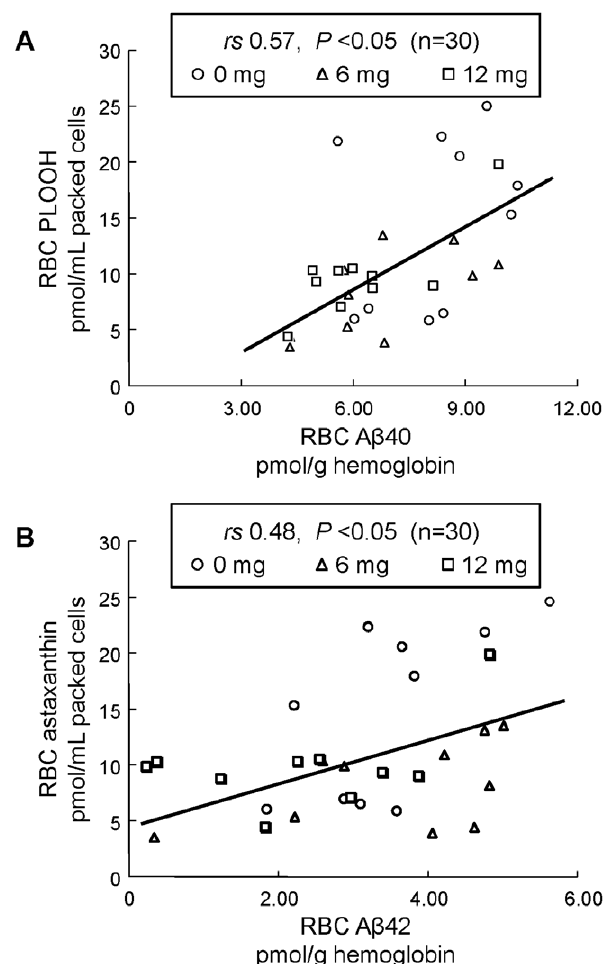
Figure 3. Correlation between RBC PLOOH and A b 40 (A) or A b 42 (B) concentration after 12 weeks administration of astaxanthin (N=30). X-axis is concentration of RBC A b . Y-axis is concentration of RBC PLOOH [phosphatidylcholine hydroperoxide (PCOOH) and phosphatidylethanolamine hydroperoxide (PEOOH)] that had been measured in our former human study [12].